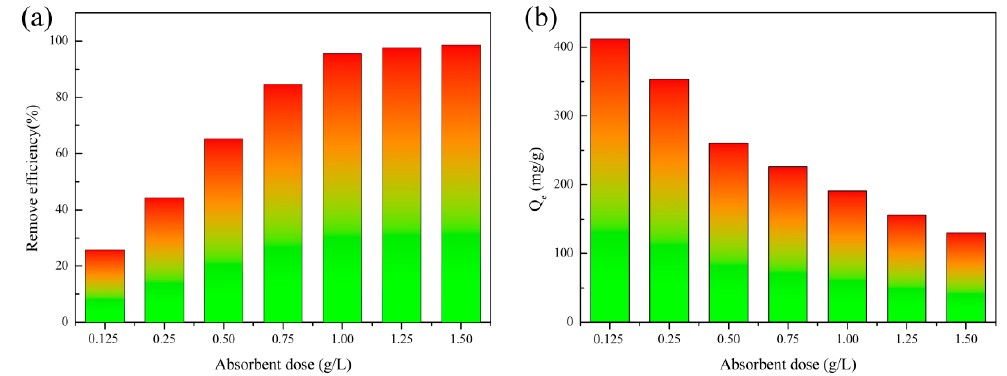
Figure 10. ( a ) The adsorption percentage and ( b ) adsorption amount of RhB on WS 2 /WO 3 as a function of the adsorbent content at 30 °C, pH 6.0, and 𝐶 (cid:2919)(cid:2924)(cid:2919)(cid:2930)(cid:2919)(cid:2911)(cid:2922) 200